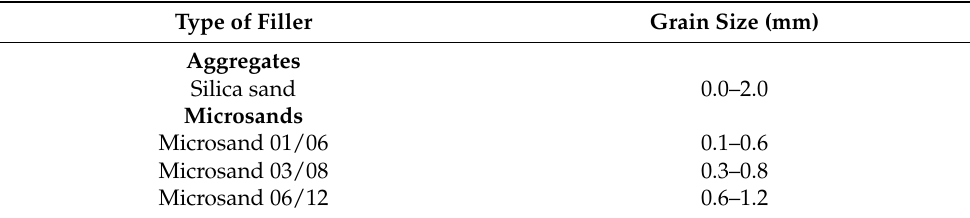
Table 2. Fractions of aggregates, sands, and microsands used in this study.